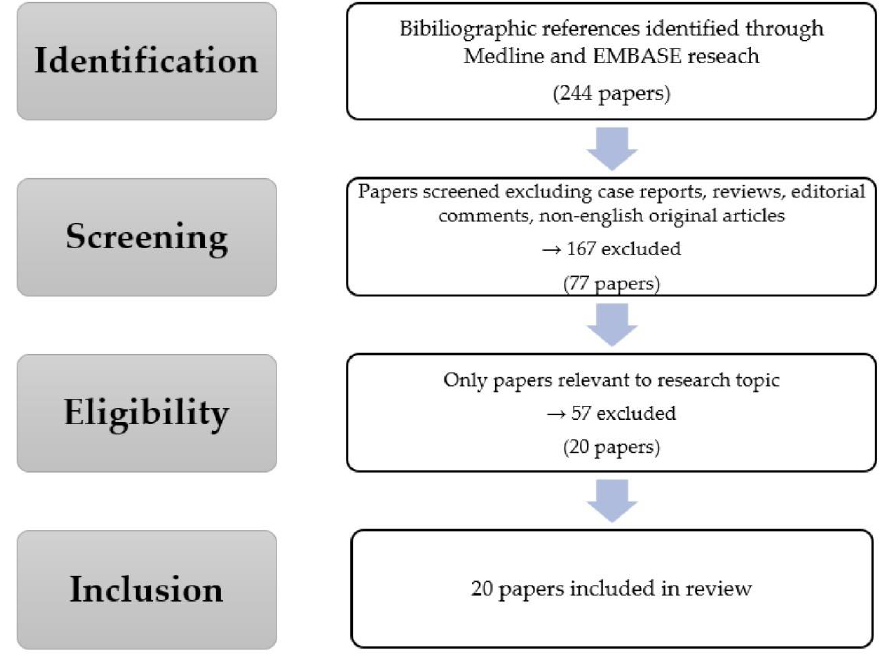
Figure 1. Flow diagram of the literature review for artificial intelligence bladder cancer studies.